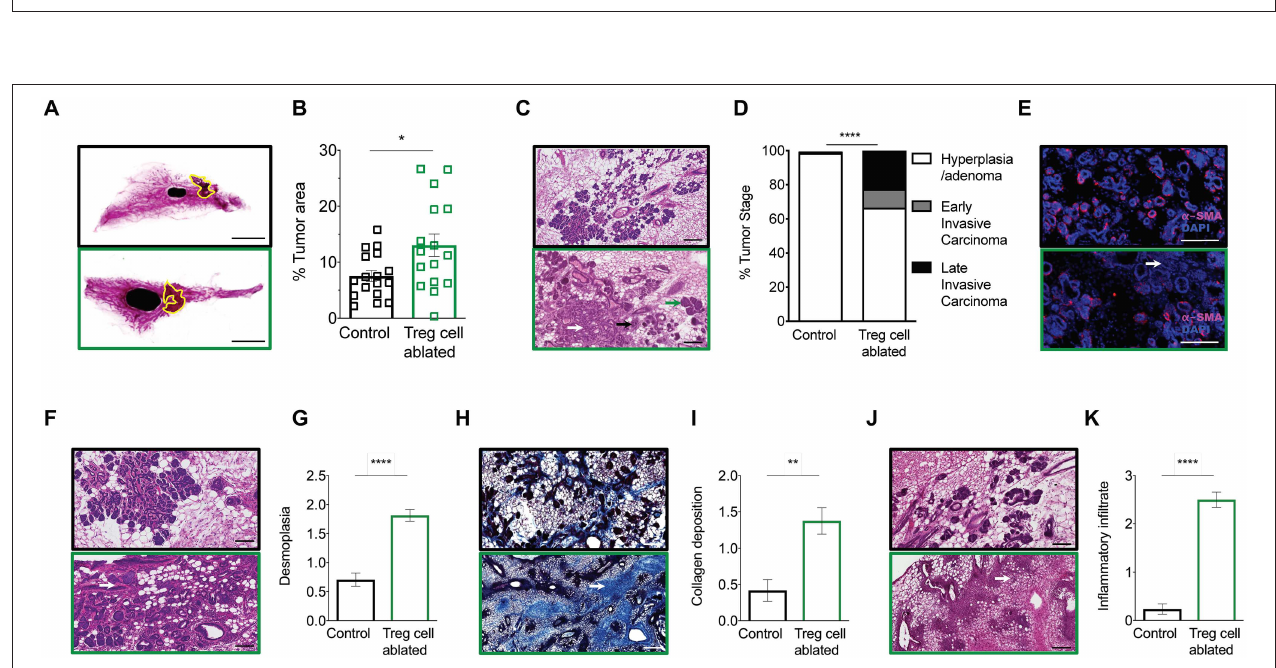
FIGURE 2 | Treg cell ablation results in advanced tumor staging. (A,B) 10-week-old mammary gland whole mount representative images (A) and quantification (B) of the percentage of tumor area of control (black) and Treg cell-ablated (green) mice ( n = 16–17 individual mammary glands). Scale bars represent 5mm, * p = 0.0405 calculated by Mann-Whitney test. (C,D) Representative image (C) and quantification (D) of tumor stage. Arrows indicate examples of various tumor stages: hyperplasia/adenoma (green arrow), early invasive carcinoma (black arrow), and late invasive carcinoma (white arrow) (E) α -SMA myoepithelial staining confirming disruption of myoepithelial layer (F,G) , representative image (F) and quantification (G) of desmoplasia; (H,I) representative image of Masson trichome staining (H) and quantification (I) of collagen deposition; and (J,K) representative image (J) and quantification (K) of inflammatory infiltration. (E,F,H,J) White arrows indicate examples of histological observation. Values are expressed as mean ± SEM. Tumor staging was compared by two-way ANOVA, **** p < 0.0001; other comparisons were done by Mann-Whitney test. **** p < 0.0001 and ** p = 0.0021. Data were pooled from four independent experiments. (C,E,F,H,J) Scale bars represent 250 µ m.